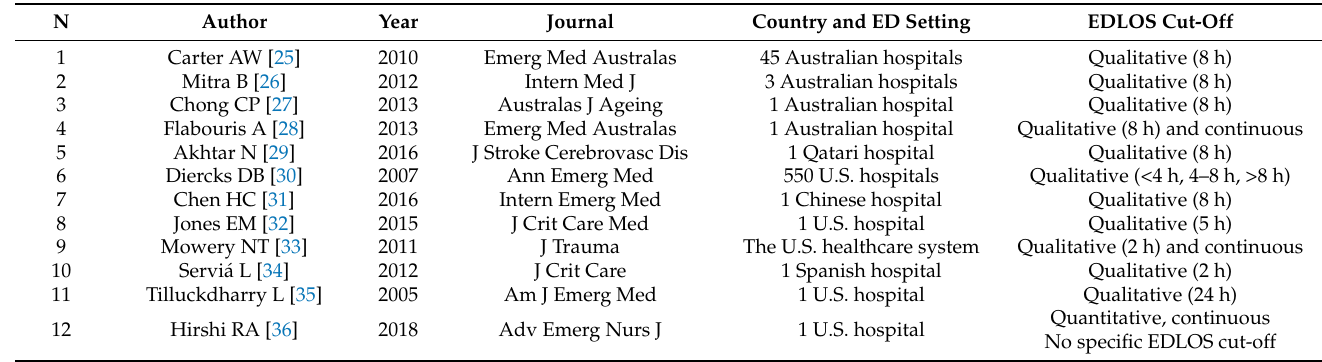
Table 1. Characteristics of the selected studies for the systematic